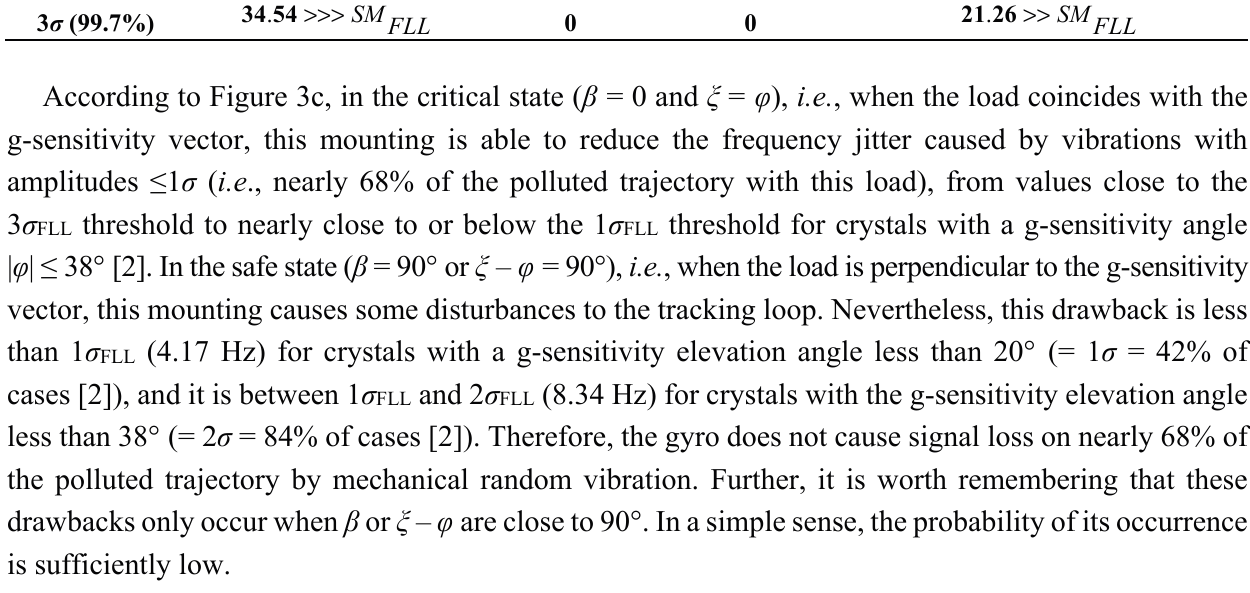
Figure 19b Fixed Using Oscillator